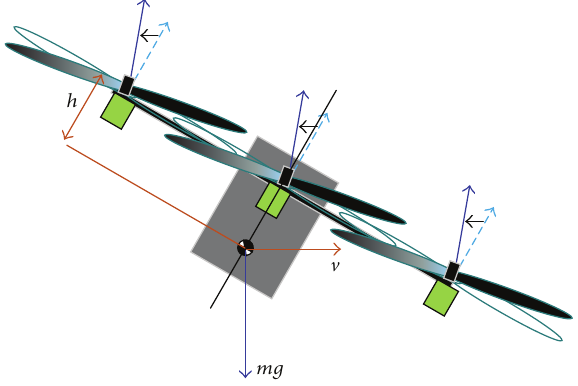
Figure 6: Effect of blade flapping